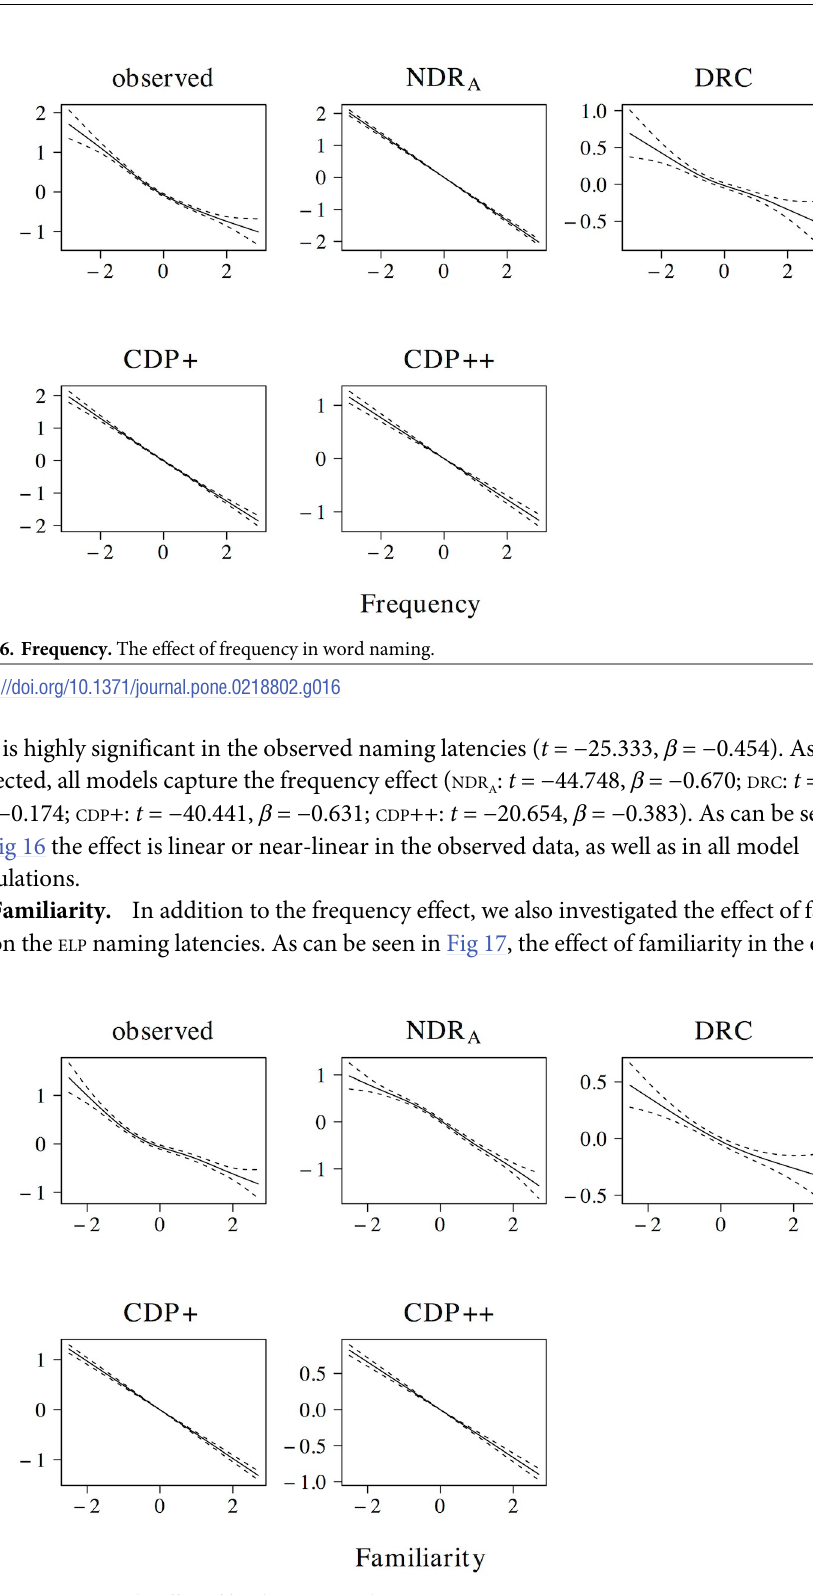
Fig 17. Familiarity. The effect of familiarity in word